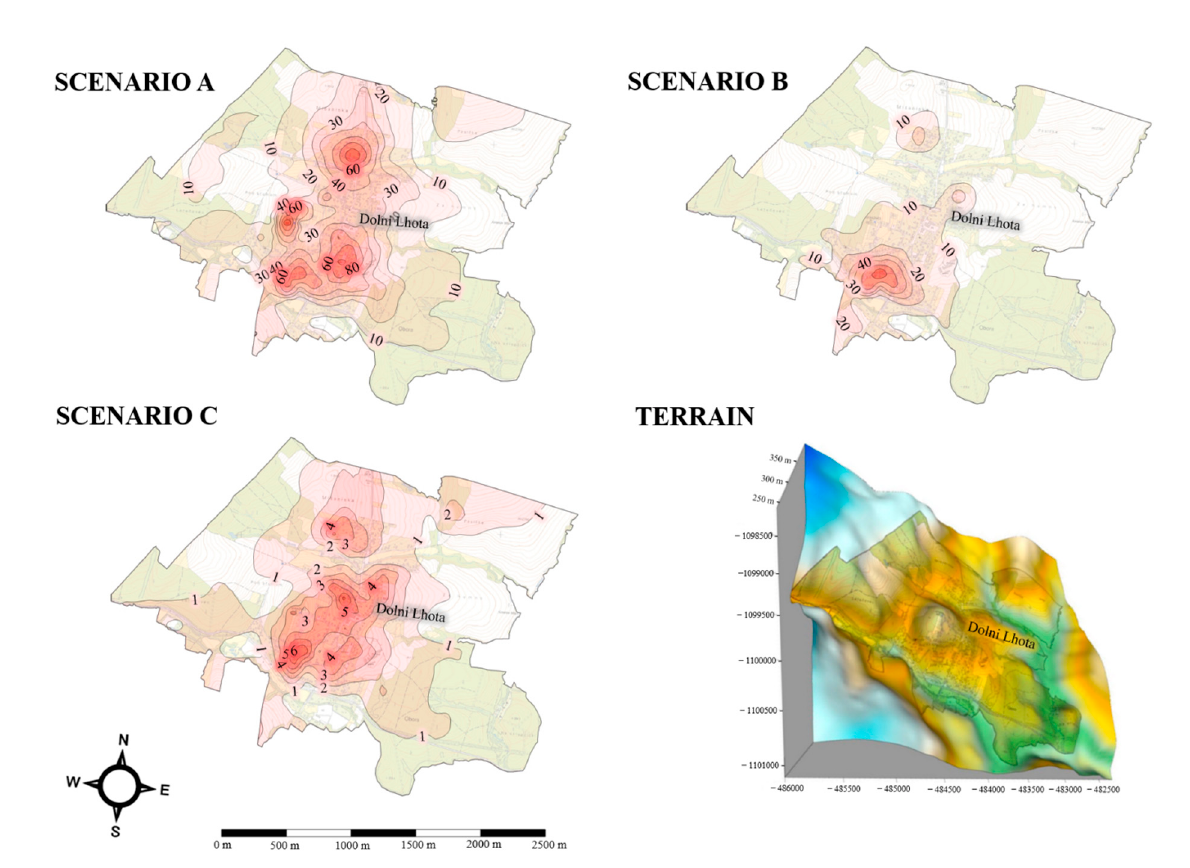
Figure 2. Particulate emissions dispersion model for the location Dolni Lhota.